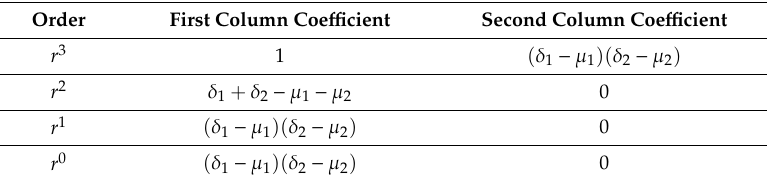
Table 1. The Routh array table at point E 0 .